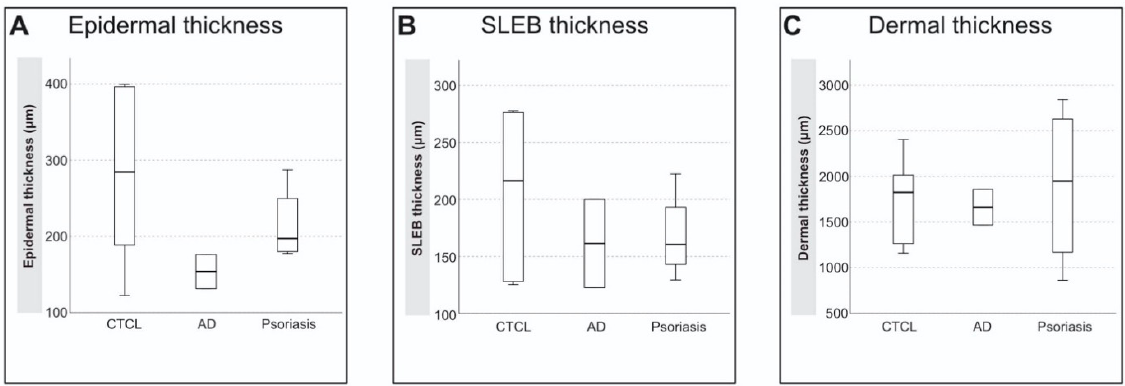
Figure 3. ( A – C ): Epidermal-, SLEB-, and Dermal thickness in CTLC, AD and Psoriasis. ( A ): Epidermal thickness in µ m